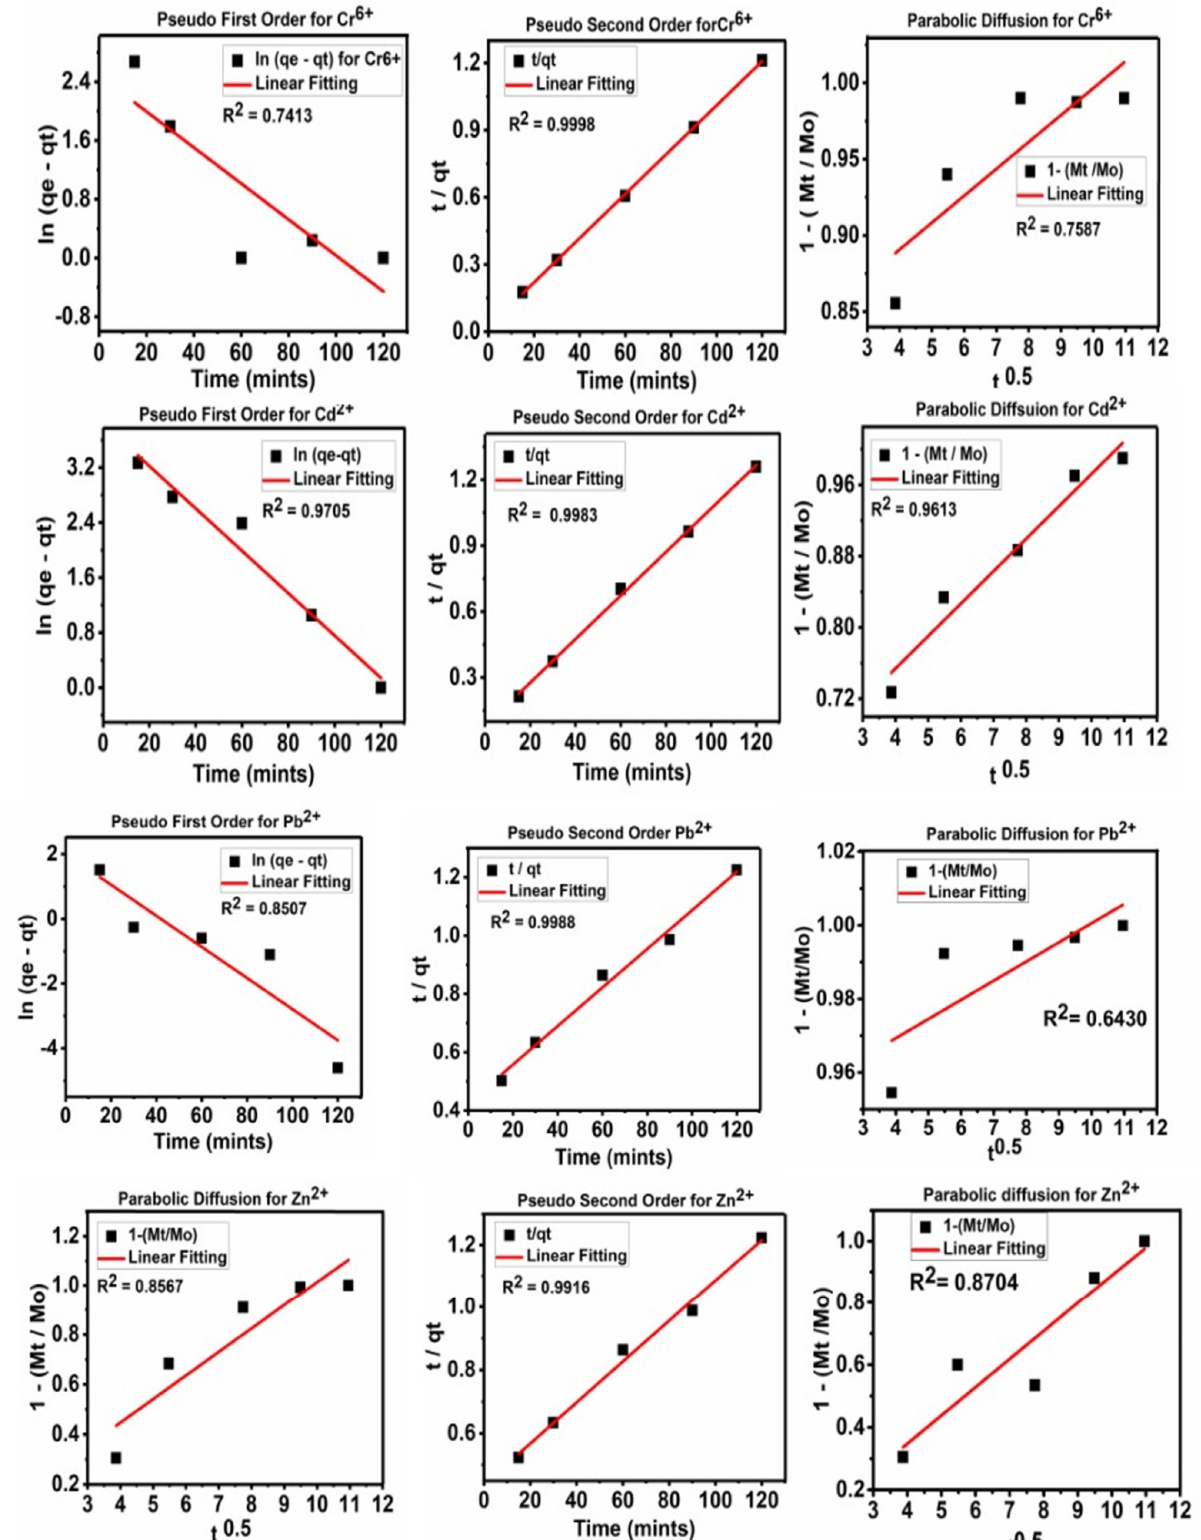
Figure 5. The kinetic fitting for the pseudo-first-order, pseudo-second-order and parabolic-diffusion models for the adsorption of the heavy metal ions; Cr 6+ , Cd 2+ , Pb 2+ and Zn 2+ on FAC.